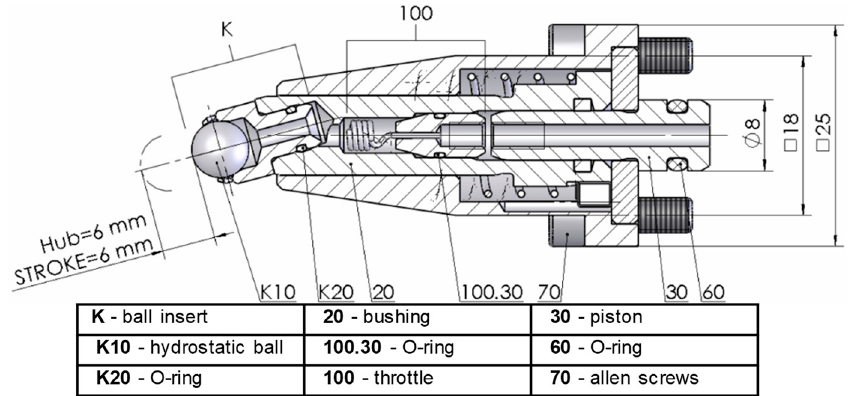
Figure 1. Scheme of deep rolling (DR) tool type HG 6.